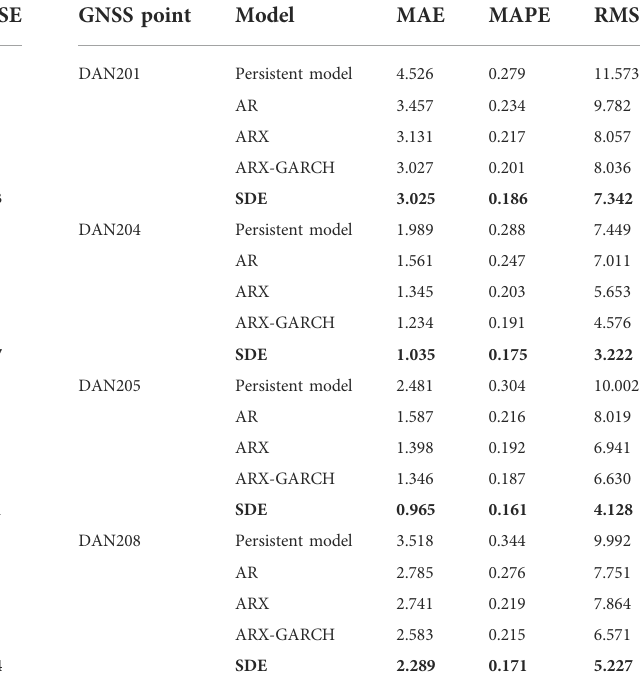
TABLE 4 Summary of 12-day ahead prediction